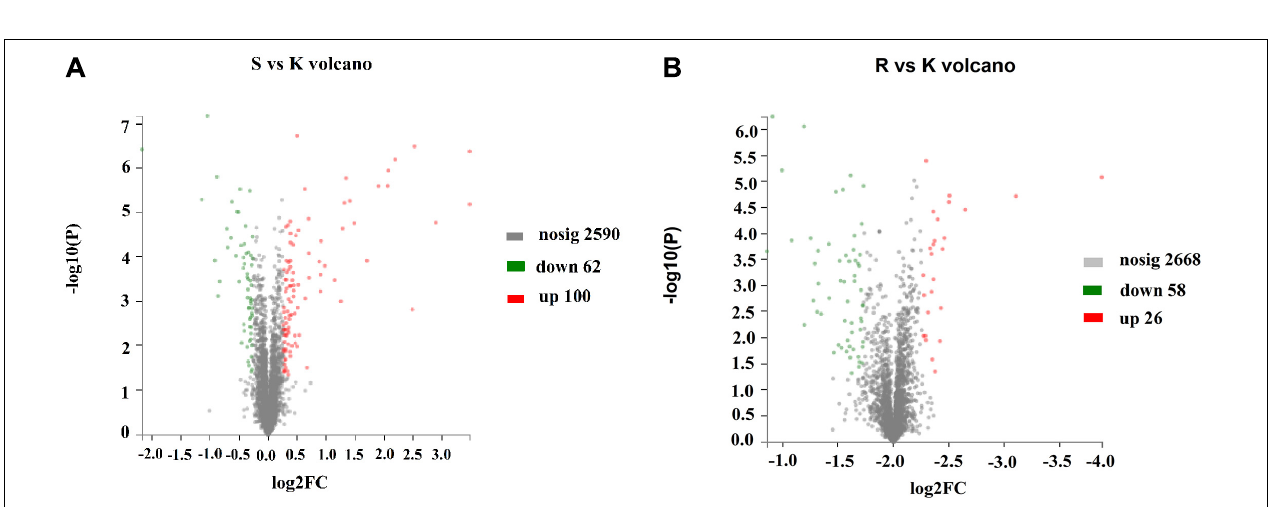
FIGURE 3 | Changes in the E. coli K12 proteome following BasS and BasR deletion. The volcano plots of the 2752 identified proteins are shown. (A) Represents the E. coli JW4073 (S)/ E. coli K12 (K) group, while (B) represents the E. coli JW4074 (R)/ E. coli K12 (K) group. The different colors indicate different fold changes. Red represents proteins with fold change values greater than 1.20, while green represents proteins with the fold change values less than 0.83 ( P < 0.05).